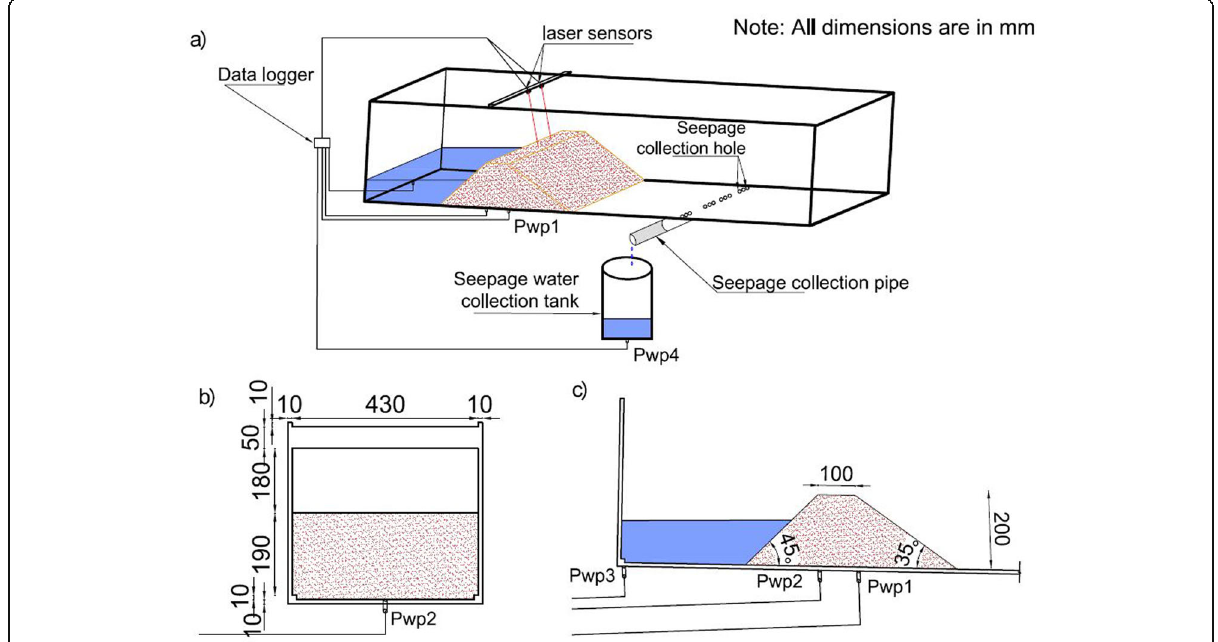
Fig. 1 Experimental setup of the flume tank. a 3D view; b cross-section; and c longitudinal